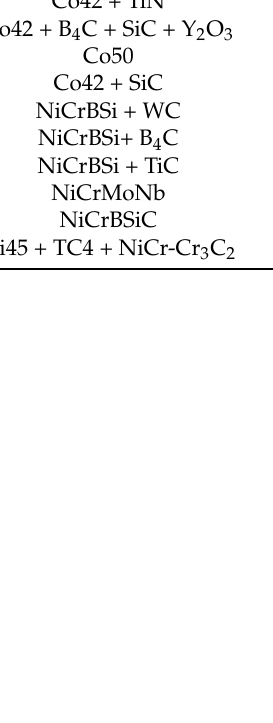
Table 3. The HEA powders for the surface modification of Ti-based alloys by LC. Cladding